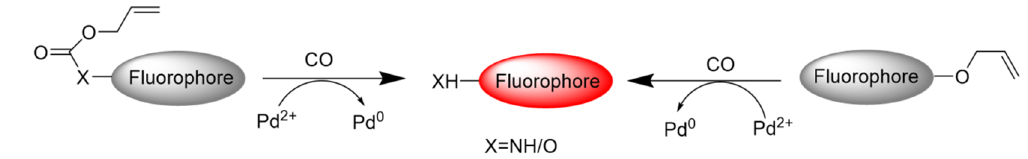
Figure 1. The mechanism diagram of Pd 0 -mediated Tsuji-Trost reaction.